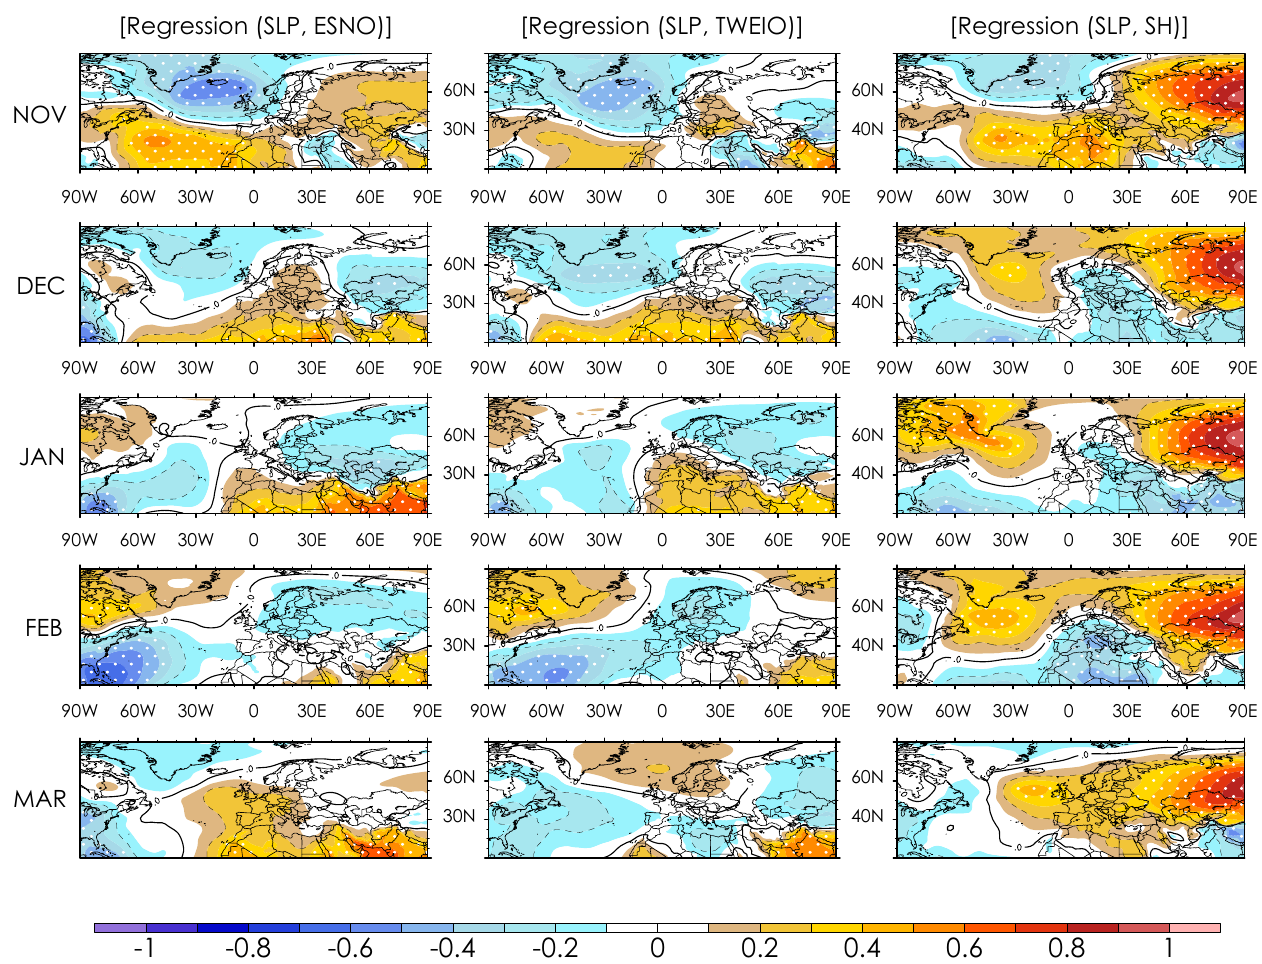
Fig. 8 Linear regression of sea level pressure anomalies onto the natural modes of climate variability. Regression of the monthly detrended sea level pressure anomalies onto the standardized indices of ENSO (1st column), TWEIO (2nd column), SH (3rd column). Stippling represents statistical signi fi cance at a 95% con fi dence level. All regression coef fi cients are